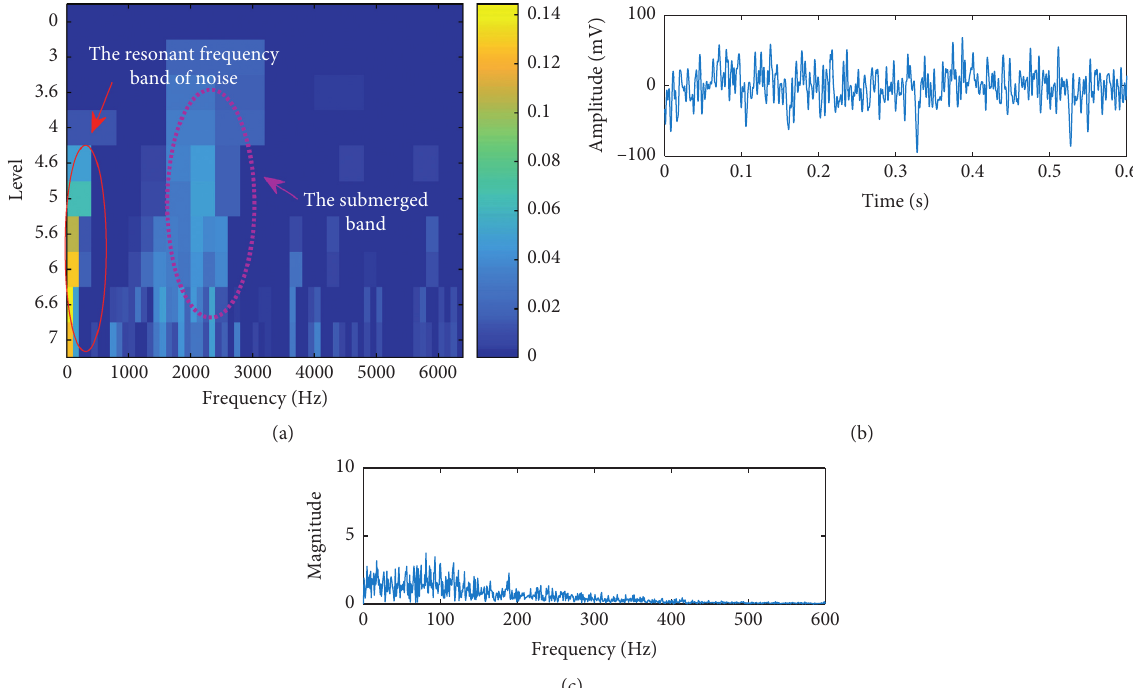
Figure 15: (a) Optimal subband selection process of the kurtogram method, (b) time-domain waveform of the optimal subband, and (c) envelope spectrum of (b).